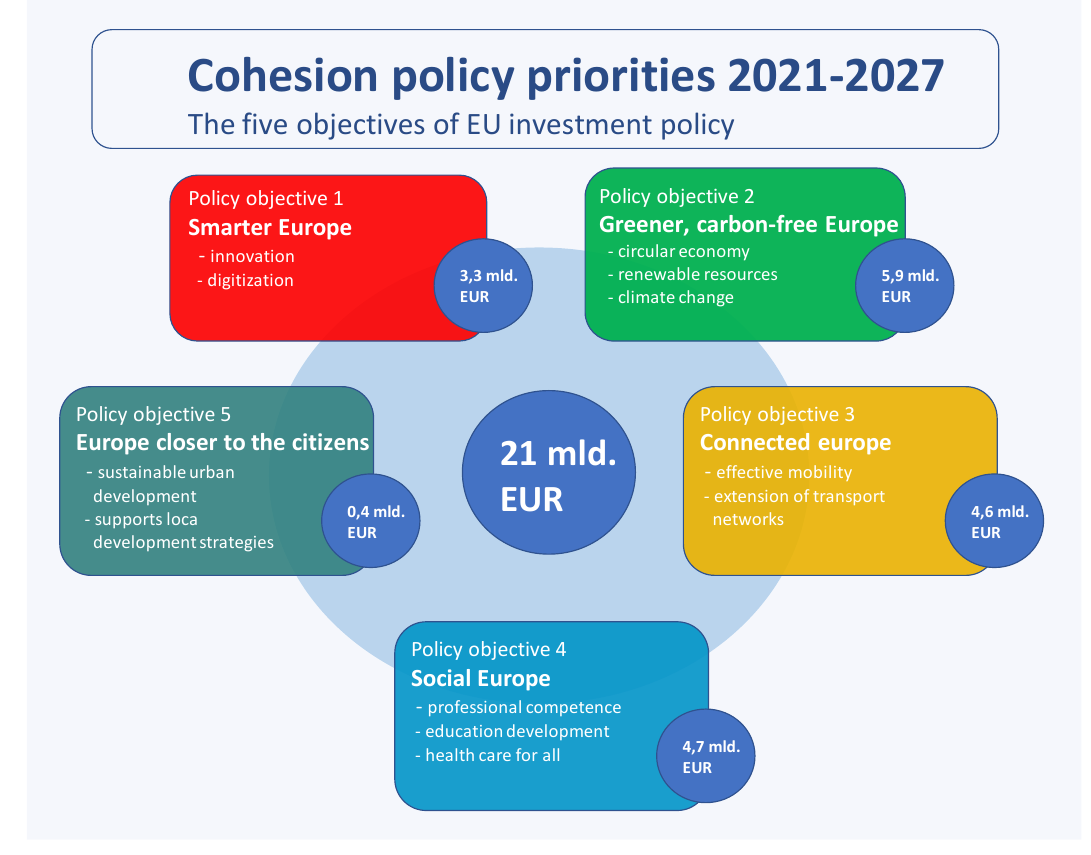
Figure 1: Structure of OP TAK focus (source: API